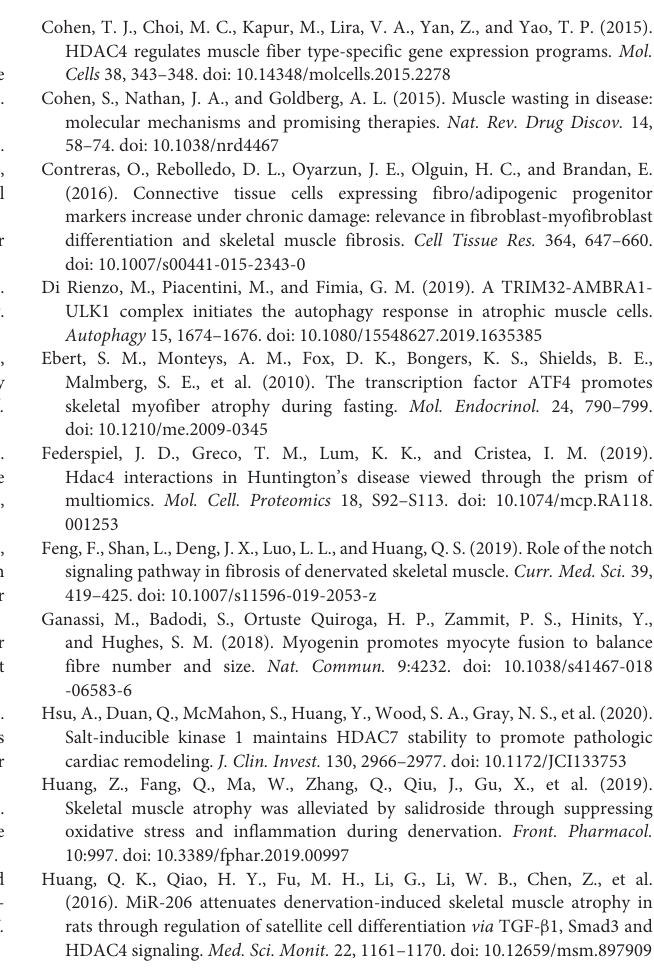
SUPPLEMENTARY FIGURE 1 | Effect of HDAC4 interference on MYOG expression. Mice in sham operation group (Sham) were injected with empty vector virus into tibialis anterior muscle. The sciatic nerve transection model was prepared after injection of HDAC4-shRNA lentivirus (H-i+Den), empty vector virus (Den) into the tibialis anterior muscle of mice 3 days. Protein levels of MYOG in muscle were detected by Western blot after denervation for 14 days. ∗∗∗ P < 0.001 vs. sham group. ## P < 0.01 vs. denervated group. SUPPLEMENTARY FIGURE 2 | Overexpression of MYOG causes atrophy of the C2C12 myotubes. C2C12 was transfected with empty vector lentivirus (Ctrl) and MYOG overexpression lentivirus (G-OE) after induced differentiation for 3 days, respectively. After 3–4 days, (A,B) MHC staining was used to analyze the diameter of the C2C12 myotubes. (C) The expression levels of MYOG, MyHC, MuRF1 and MAFbx were detected by Western Blot. * P < 0.05 vs. Ctrl